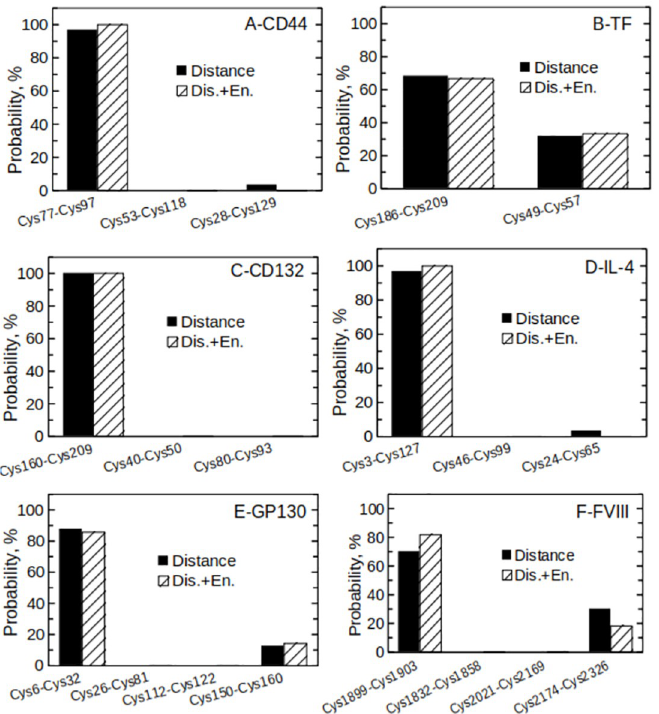
Fig 4. Distance- or distance+energy-based criteria to identify redox-labile disulfide bonds. Histograms showing the probability that each disulfide is reduced by TCEP according to the distance- (plain black bars) or distance+energy- based (dashed bars) criteria. The different panels refer to CD44 (A), tissue factor (B), CD132 (C), IL-4 (D), the D1 and D2 domains of GP130 (E), and FVIII light chains